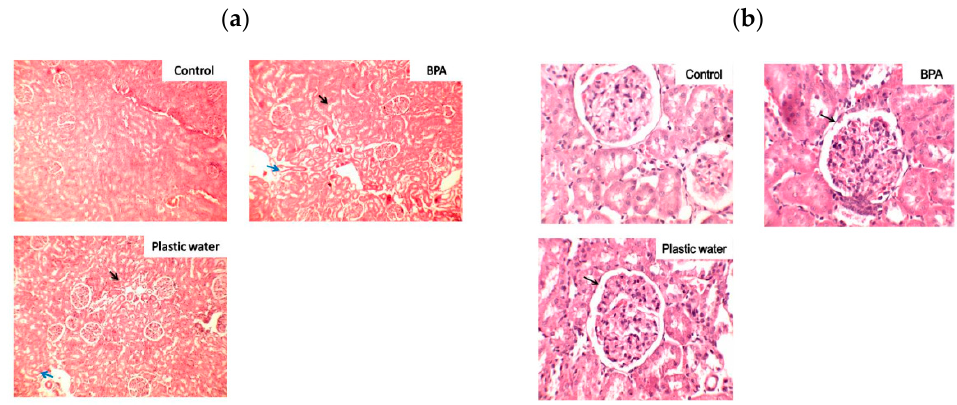
Figure 2. ( a ) Photomicrograph of kidneys of rats magnified 100 × . The black arrows show hyperplastic changes in the treated groups and blue arrows indicate tubular thinning. ( b ) Photomicrograph of kidneys of rats magnified 400 × . The black arrows show reduced periglomerular space due to hyperplasia in the treated groups. Lymphocytic infiltration is also seen in the treated groups. Liver: Liver sections from control group rats showed central veins with healthy hepatocytes.